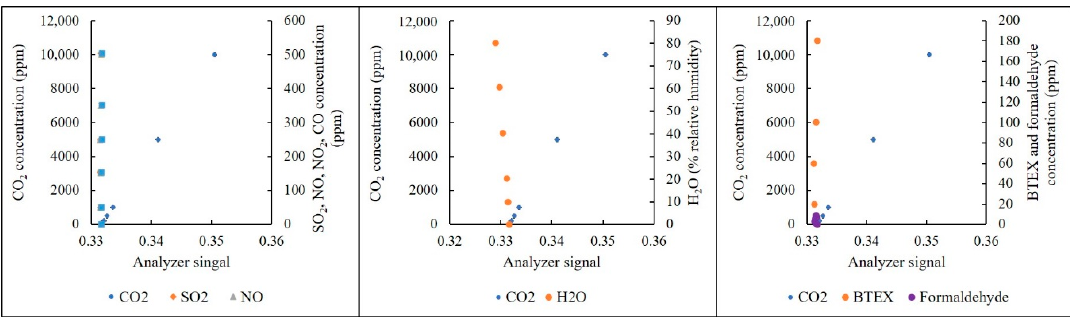
Figure 8. Effects of interference gases on the NDIR analyzer at the ppmv channel.